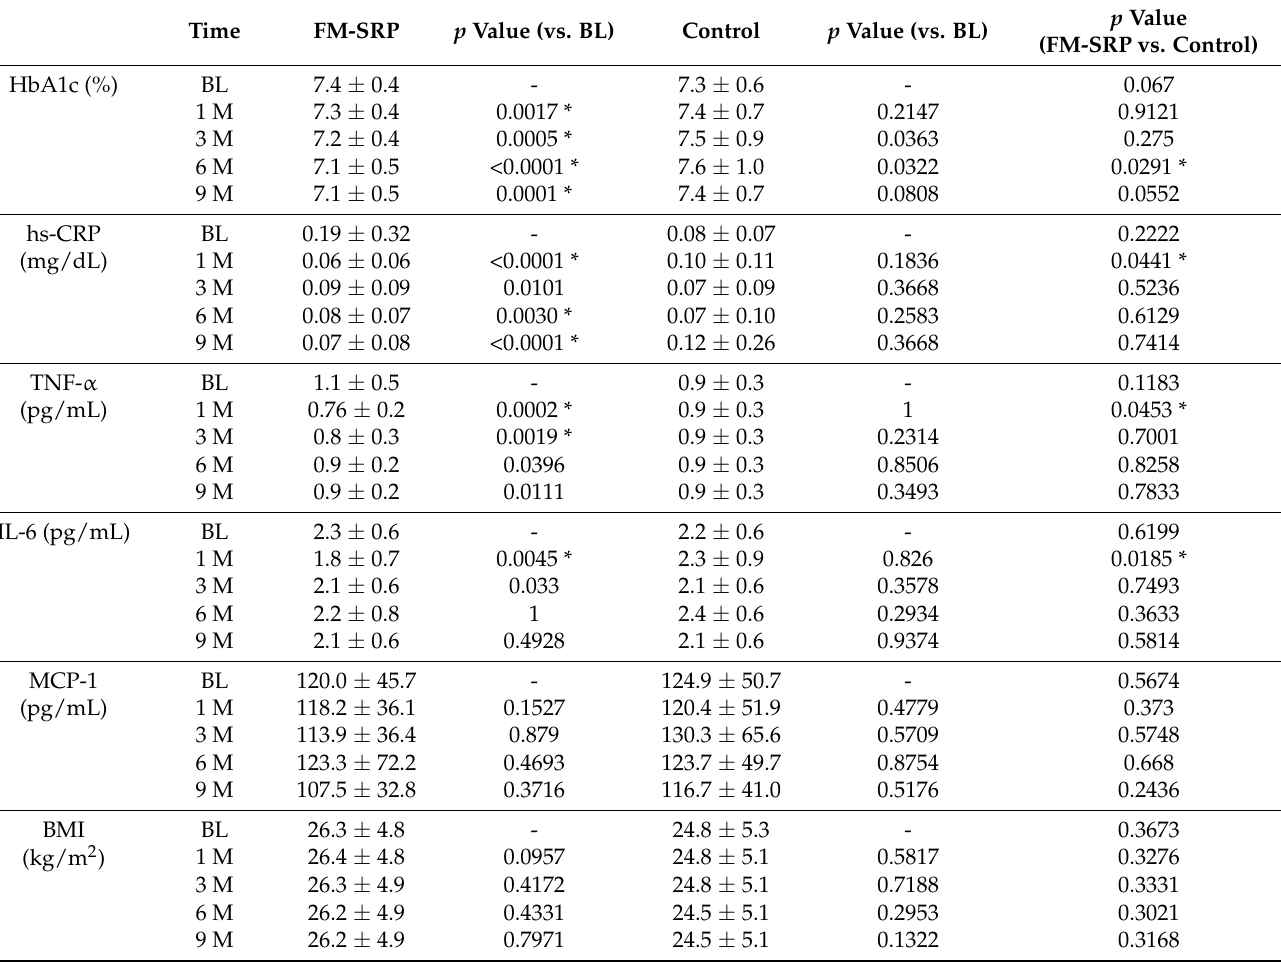
Table 4. HbA1c and inflammatory